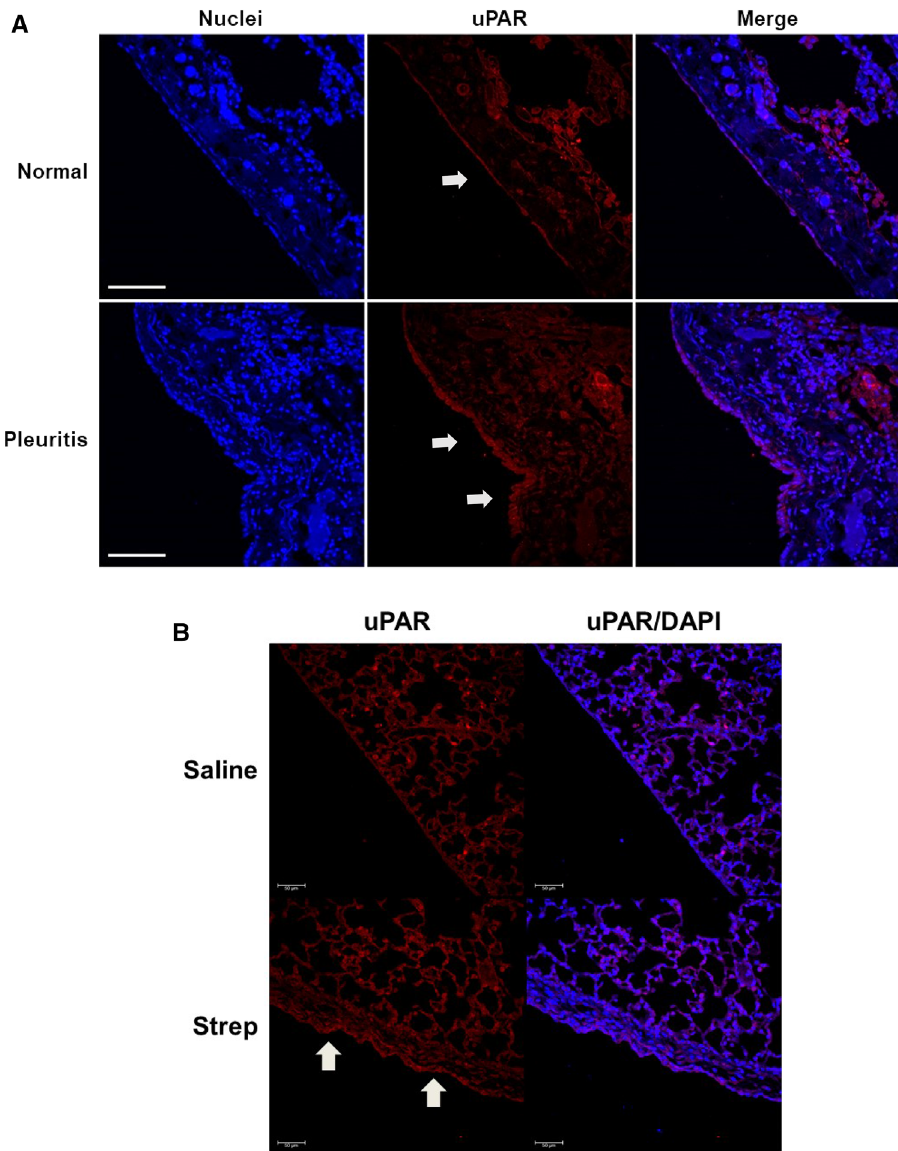
Figure 1. uPAR is expressed in normal and human nonspecific pleuritis. Lung tissue sections from normal patients and patients diagnosed with nonspecific pleuritis were immunofluorescently labeled for uPAR. ( A ) uPAR expression (cyan) was detected at the pleural surface of nonspecific pleuritis tissue and normal pleural tissues. Images are × 25 and are representative of the findings of 30 fields/slide and 3–4 patients/group. Solid arrows indicate areas of uPAR positivity along the pleural surface. White bar indicates 100 µm. ( B ) uPAR expression (red) was detected in lung sections of S. pneumonaie infected and saline treated WT mice. Images are at × 25 and are representative of the findings of 15 fields/slide and 3–4 mice/treatment. Solid arrows indicate areas of uPAR positivity along the pleural surface. White bar indicates 50